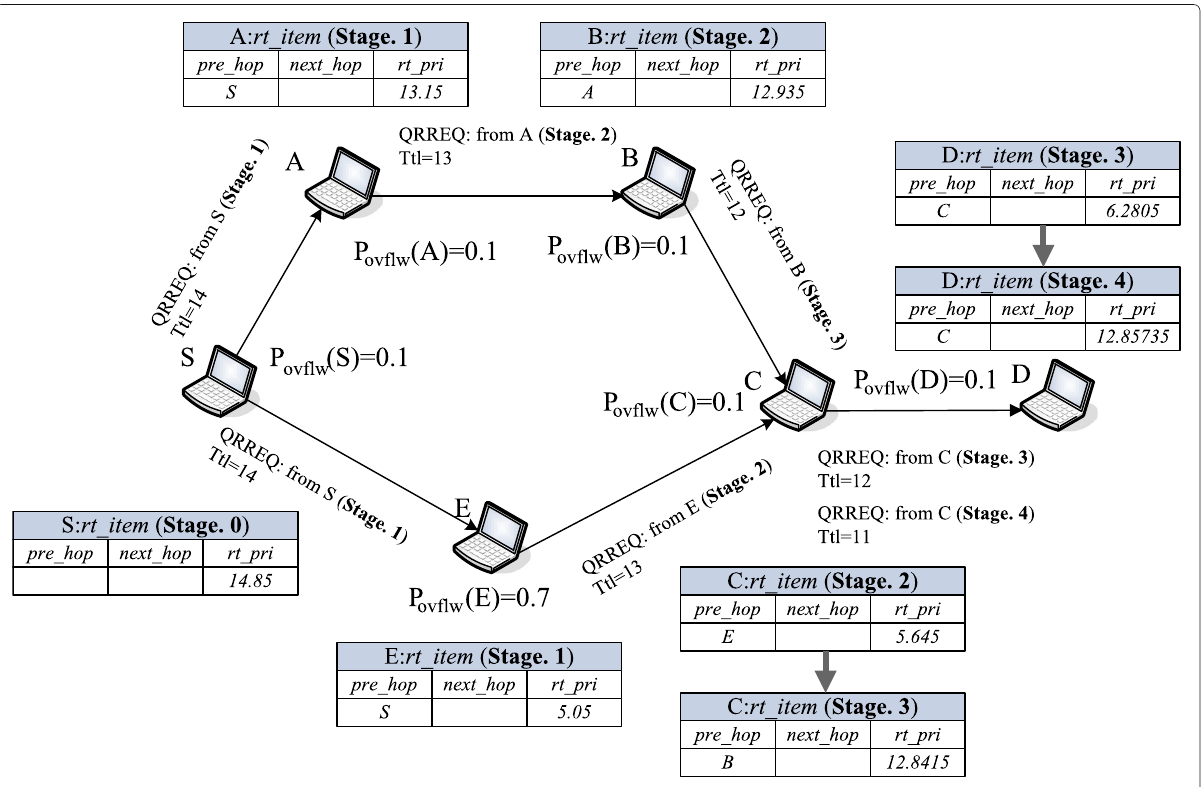
Fig. 3 The example of QoS route request process